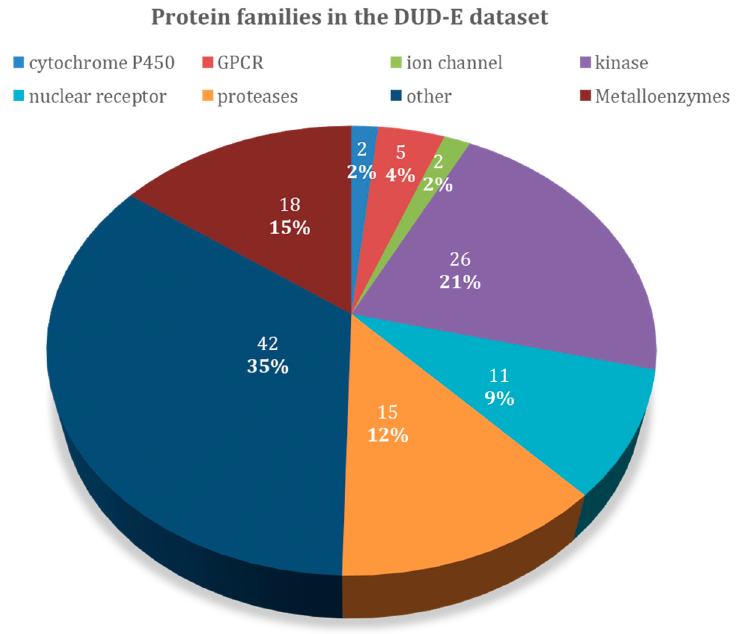
Figure 1. Overview of the protein target families of the Directory of Useful Decoys–Enhanced (DUD–E) dataset. Table 1. Protein targets evaluated in this study as part of DUD–E with indication of the different classes of targets considered .